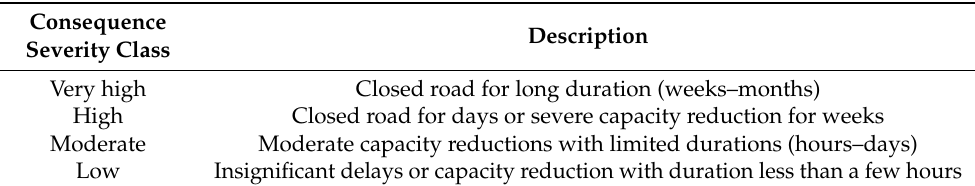
Table 7. Adopted consequence severity